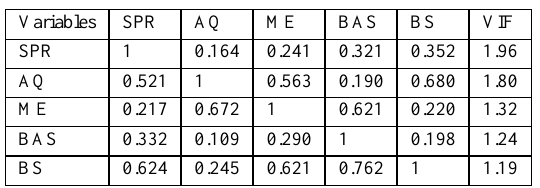
Table 1: Correlation Coefficients for Multicollinearity Test